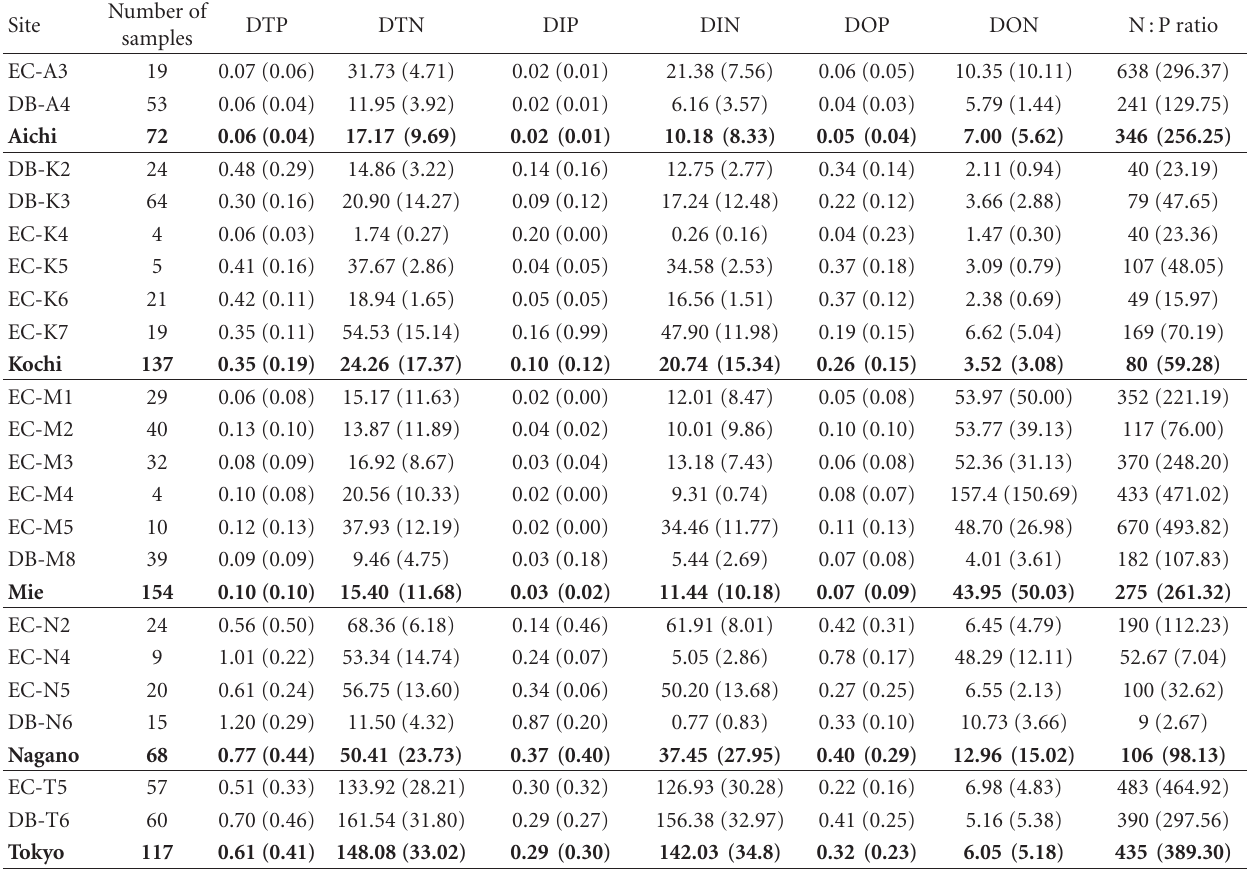
Table 3: Means for nutrient concentrations ( µ molL − 1 ) and the molar N: P ratio at the 20 sites across the five study regions in Japan (standard deviations are in